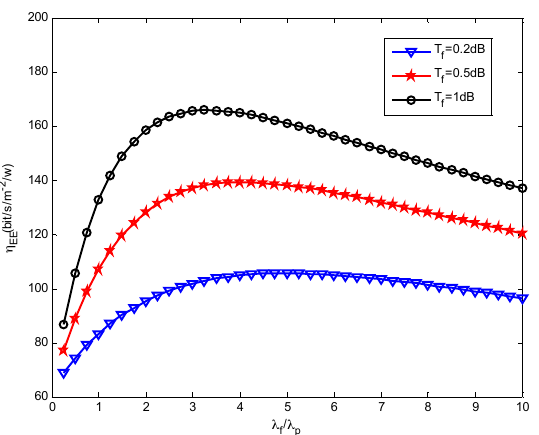
10 of 17 Figure 4. Effect of femtocell density on the femto-tier coverage performance. We then assess how the small cells density affects the energy efficiency. Figures 5–7 present the effects that the picocell and femtocell deployment density ratio has on the system energy efficiency under the various SIR thresholds. In these simulations, we set the picocell deployment density λ p = 0.01 /m 2 . It can be found out that the energy efficiency η EE rises rapidly to a peak value and then decreases with the increasing deployment density ratio λ f / λ p . This proves that deploying the